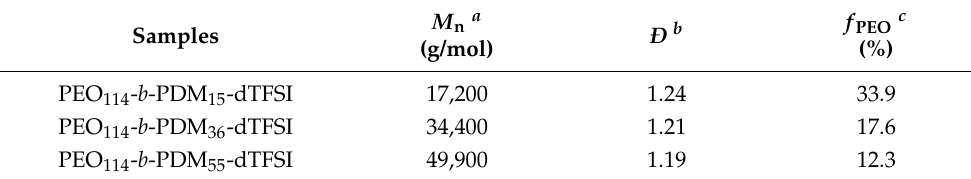
Table 1. Molecular characteristics of the PEO 114 - b -PDM n -dTFSI